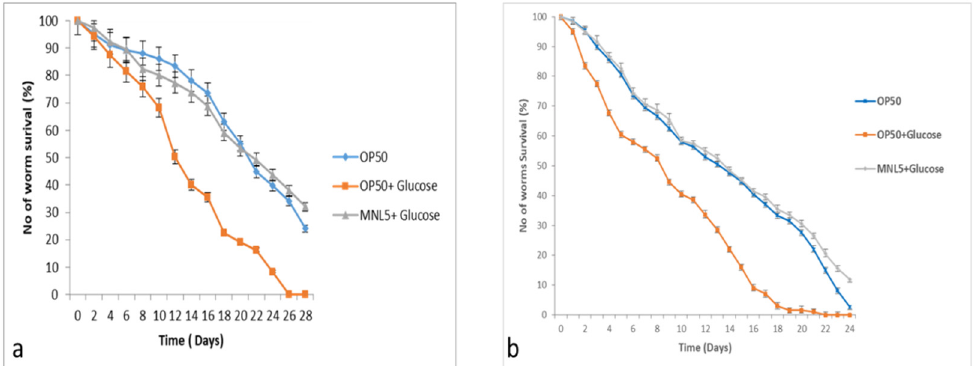
Figure 5. Glucose supplements diet by lifespan of C. elegans . ( a ) DAF-2; ( b ) LIU1 model. The treatments such as, OP50 (Control), MNL + GLU ( P. acidilactici MNL5 with Glucose) [Treatment]), OP50+GLU ( E. coli OP50 with Glucose [Positive Control]; in each experiment, 100 worms were administered, repeated twice and plotted using OASIS II. All results are presented as the means ± standard error mean.